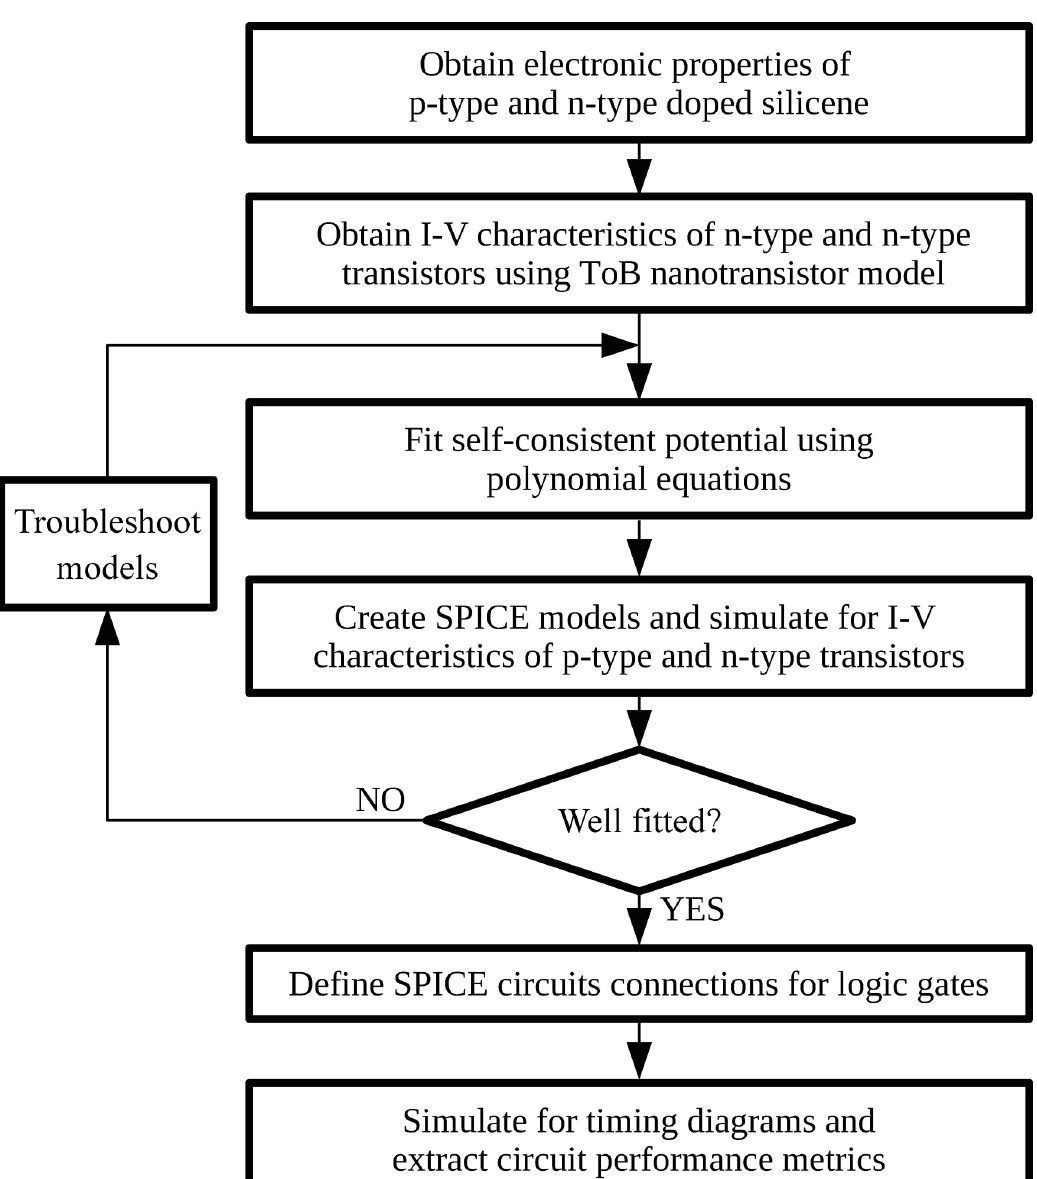
Fig 2. Modelling and simulation flow chart of this work.